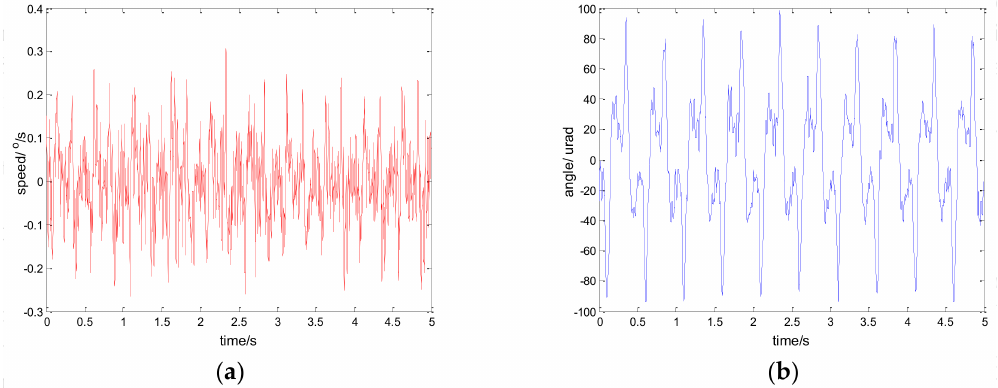
Figure 19. Experiment results of robust SMC with Euler. d = sin ( 2 π × 2 t ) : ( a ) speed; and ( b ) tracking error, RMS = 39.5665